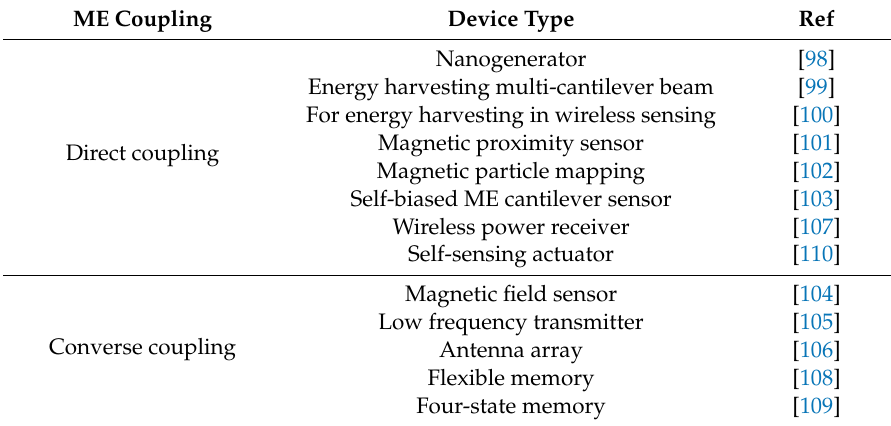
Table 2. IoT ME device